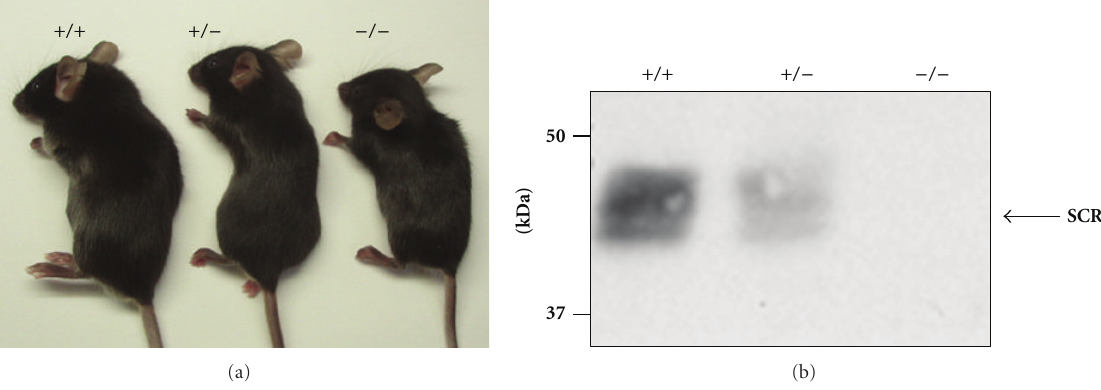
Figure 1: Inhibition of SCRAPPER protein expression in Scrapper -knockout (SCR-KO) mice. (a) Appearance of SCR-KO mice (Yao et al. [1], with permission from Elsevier). (b) Western blot analysis of SCRAPPER in wild-type (WT) or SCR-KO mouse hippocampus. Five microgram of protein in the hippocampal homogenate was applied to each lane and immunoblotted by the anti-SCRAPPER antibody. The SCRAPPER signal was not observed for SCR-KO mice. + / +, WT; + / − , heterozygote; − / − , homozygote SCR-KO